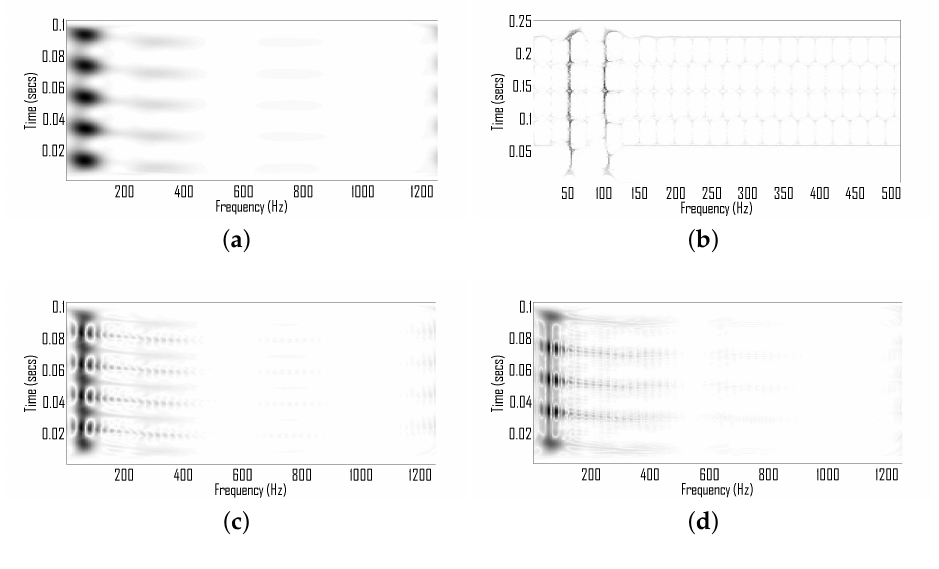
Figure 6. A real world PQ signal showing both tones and spikes.